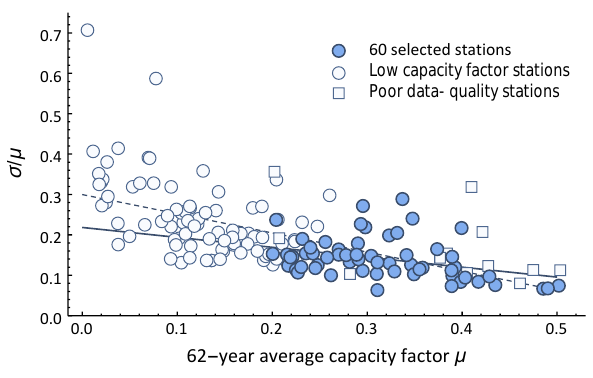
Figure 1. Ratio of the standard deviation σ of the 62 annual average capacity factors to their mean µ , vs. µ , for each station. Filled sym- bols: the 60 selected stations; open symbols: the discarded stations. Dashed line is the least-squares linear trend for all the 156 stations (slope of − 0 . 47, R 2 = 0 . 39); solid line is the least-squares linear trend for the 60 selected stations (slope of − 0 . 24, R 2 = 0 .